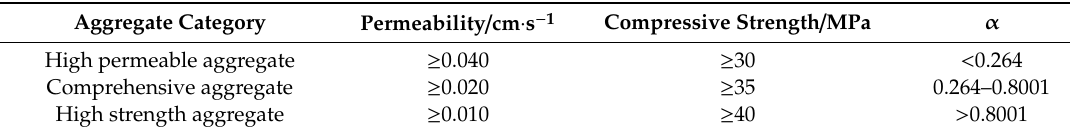
Table 6. Performance index and particle group characteristic parameter range of three types of aggregates.